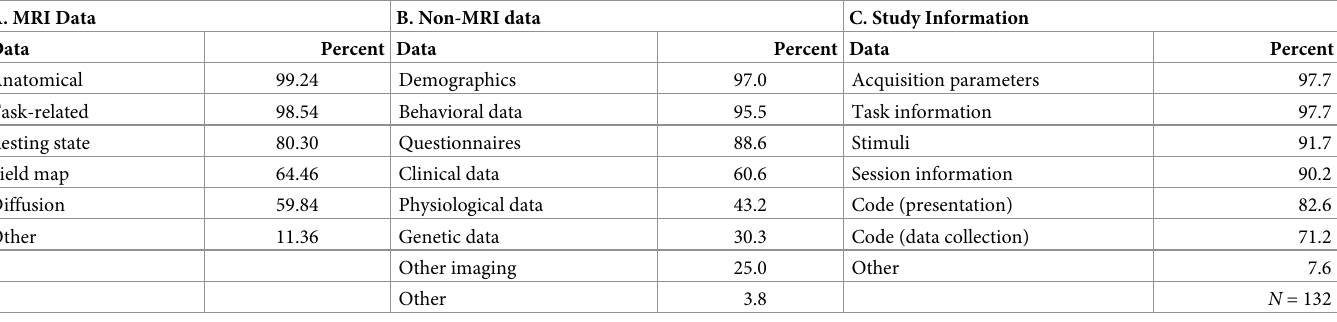
Table 3. Types of data